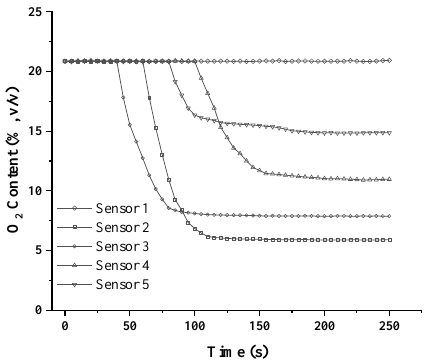
Figure 3. Oxygen concentrations in air, and the equilibrium time of the oxygen-concentration monitoring equipment in the composting pile.